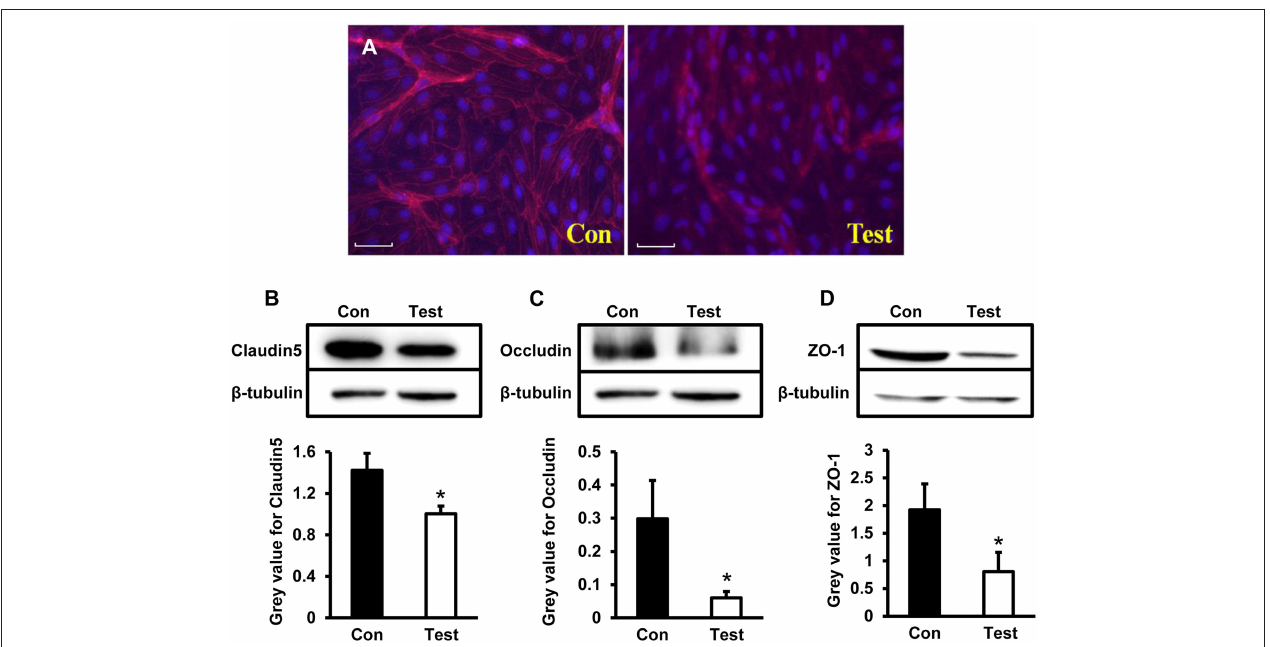
FIGURE 4 | Quantity analysis of tight junction-associated proteins (Claudin5, Occludin, ZO-1) in HBMVECs. (A) Representative images of Immunofluorescence staining. The images showed that positive signals of Claudin5 distributed consecutively in membrane of control cells, and expression levels decreased after HEV infection and positive signals translocated into cell cytoplasm (Red: Claudin, Blue: DAPI). (B) Western blot indicated that expression levels of Claudin5 were significantly reduced in HEV-infected cells compared to control group ( * P < 0.05). (C,D) Deceased protein levels of Occludin and ZO-1 were also detected in HEV-infected cells ( * P < 0.05).